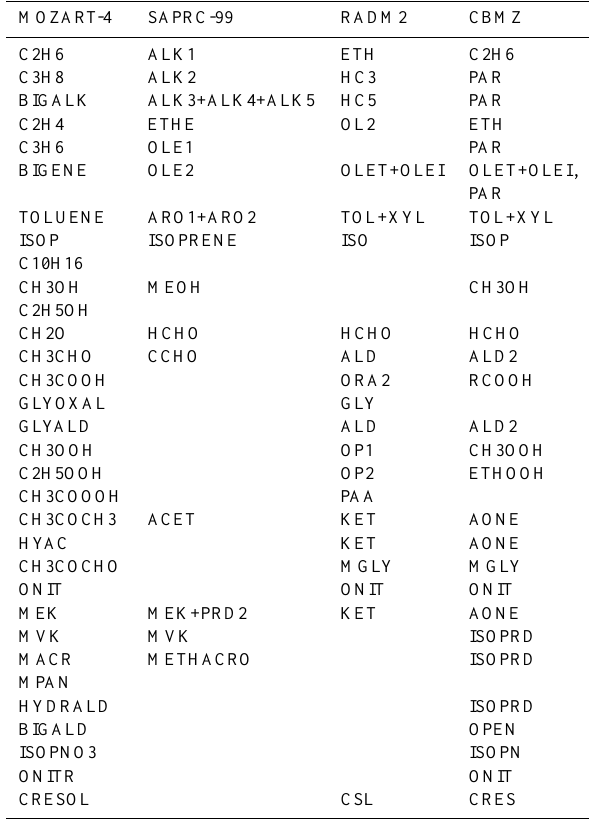
Table 7. Approximate matching of MOZART-4 VOCs to other